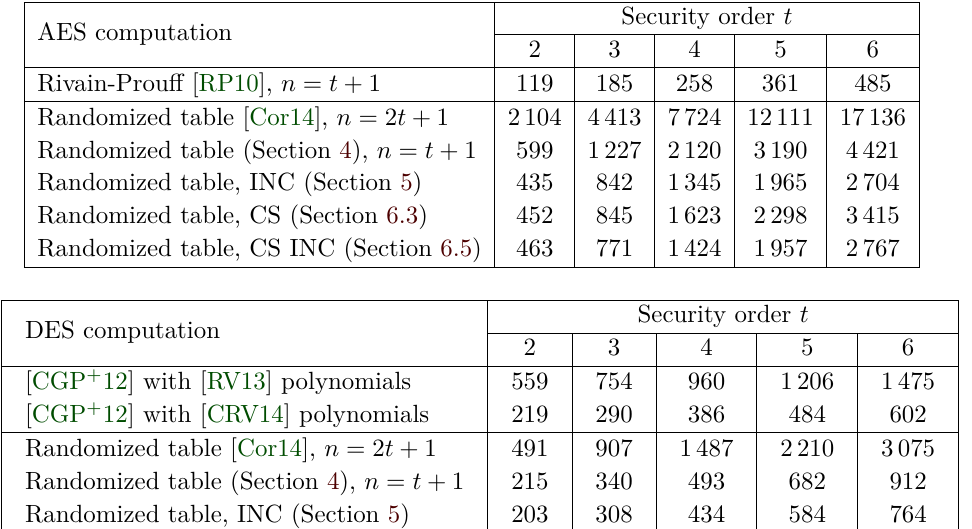
Table 2: Running time in thousands of clock cycles of protected implementations of AES and DES, up to security order t = 6, with n = t + 1 shares (except for the original countermeasure in [Cor14] with n = 2 t + 1 shares). The implementation was done in C on an iMac running a 3 . 2 GHz Intel processor. The running time of the unprotected AES implementation is 1 . 6 · 10 3 cycles. The running time of the unprotected DES implementation is 9 . 6 · 10 3